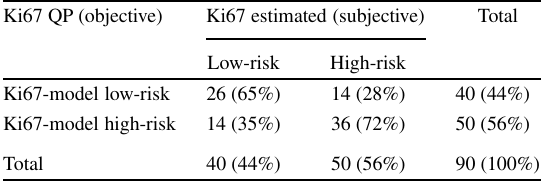
Correlation of estimated (subjective) versus measured (objective) Ki67